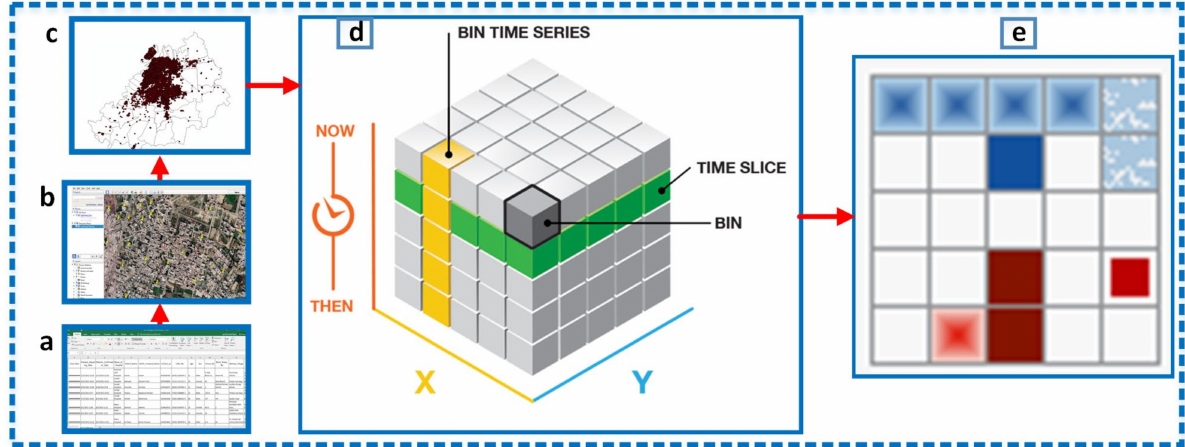
Figure 3. Towards space–time cube aggregation and Emerging Hot Spot Analysis (adapted from http://ESRI.com (accessed on 12 June 2020)): ( a ) Ten Excel sheets contain dengue cases from 2007–2016. ( b ) Geocoding in Google Earth and KML creation for all years. ( c ) KML to feature-classes conversion (2007–2016) and record joining. ( d ) Creation of space–time cubes by aggregating points, where points are counted within each bin and the space–time trend is calculated. ( e ) Space–time cube layers are used for the Emerging Hot Spot Analysis